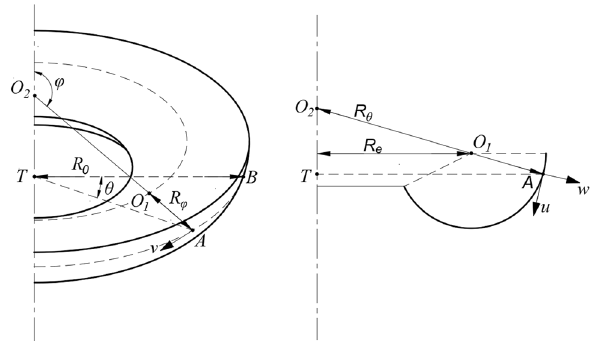
Figure 2. Schematic diagram of a rotary shell